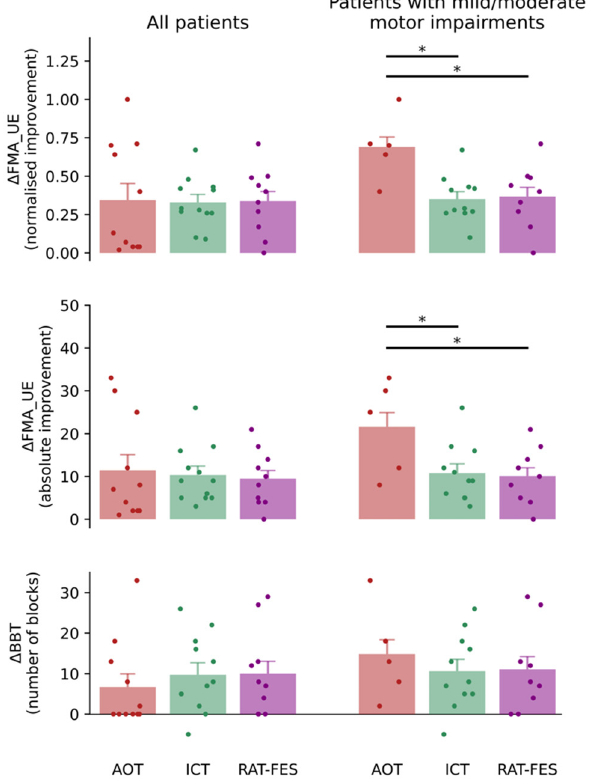
Figure 3. Normalised improvement in the FMA_UE (upper panels), absolute improvement in the FMA_UE (middle panels), and variation in the BBT from T0 to T1 (lower panels) for patients who received the three rehabilitative interventions (AOT, ICT, RAT-FES). The panels on the left and right depict the pooled data of all patients and the data of patients with mild/moderate motor impairments, respectively. The three rehabilitative interventions yielded similar motor function improvement when all patients’ pooled data were considered. In contrast, when the analysis was restricted to patients with mild/moderate motor impairments, a significant difference was found in the normalized improvement and in the absolute improvement in the FMA_UE between those treated with AOT and those who received ICT and RAT-FES. The BBT variation exhibits a similar pattern of result, although not reaching significance. Vertical bars indicate the standard error of the mean (SEM). The coloured dots indicate data from individual patients. Horizontal bars and asterisks denote significant improvement from T0 to T1 (i.e., p < 0.05). 3.2. EEG Results Not surprisingly [29,37], the spectral power of all the three frequency bands examined in the EEG signal recorded from the C3 and C4 electrodes showed a main effect of EPOCH (low-alpha: F 2,16 = 22.535, p < 0.001; high-alpha: F 2,16 = 44.16, p < 0.001; beta: F 2,16 =25.534, p < 0.001), being significantly lower in the AO epoch as opposed to SH and PO (all p s < 0.001). In addition, the power of the low-alpha frequency band shows a significant effect of SIDE (F 1,8 = 5.559, p = 0.046) and SIDE by EPOCH interaction (F 2,16 = 9.862, p = 0.001). The suppression of low-alpha power during AO is greater in the non-lesioned vs. lesioned hemisphere ( p < 0.001). No WEEK effect was detected in any frequency band. T -test showed that low-alpha suppression during AO was significantly weaker in the lesioned side than in the non-lesioned side in patients with severe impairment (t8 = 2.867, p = 0.020)